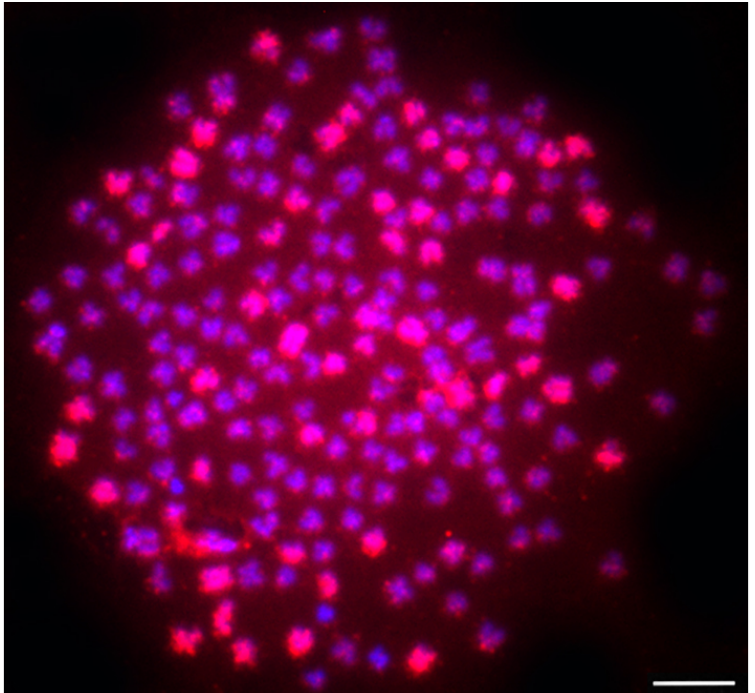
Figure 2. Genomic in situ hybridization (GISH) identified a wild Carassius hybrid female with 206 chromosomes. The 50 paternal ( C. carassius ) chromosomes are labeled with the whole genome painting probe, shown here in red. The other 156 maternal chromosomes ( C. gibelio ) are labeled by DAPI, in blue. Scale bar represents 10 µ m. Figure was modified according to Knytl et al.